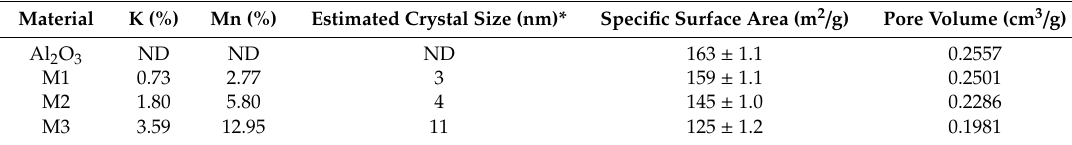
Table 1. Elemental analysis, estimated crystal size, and specific surface area.